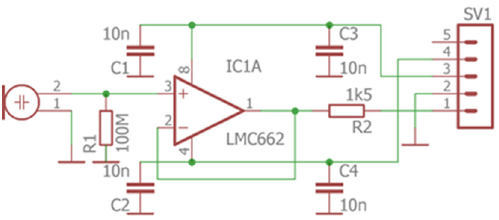
Figure 11. Electrical schematic of the microphone preamplifier.